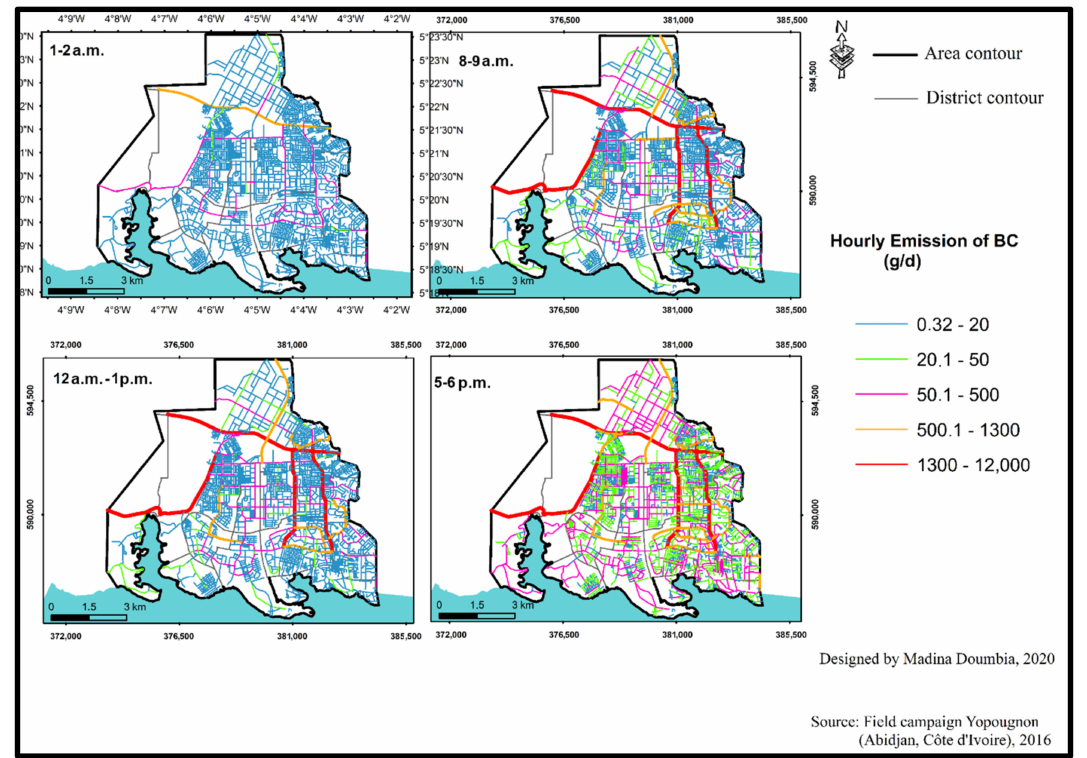
Figure 6. Spatial distribution of pollutant emissions of BC at different hours.